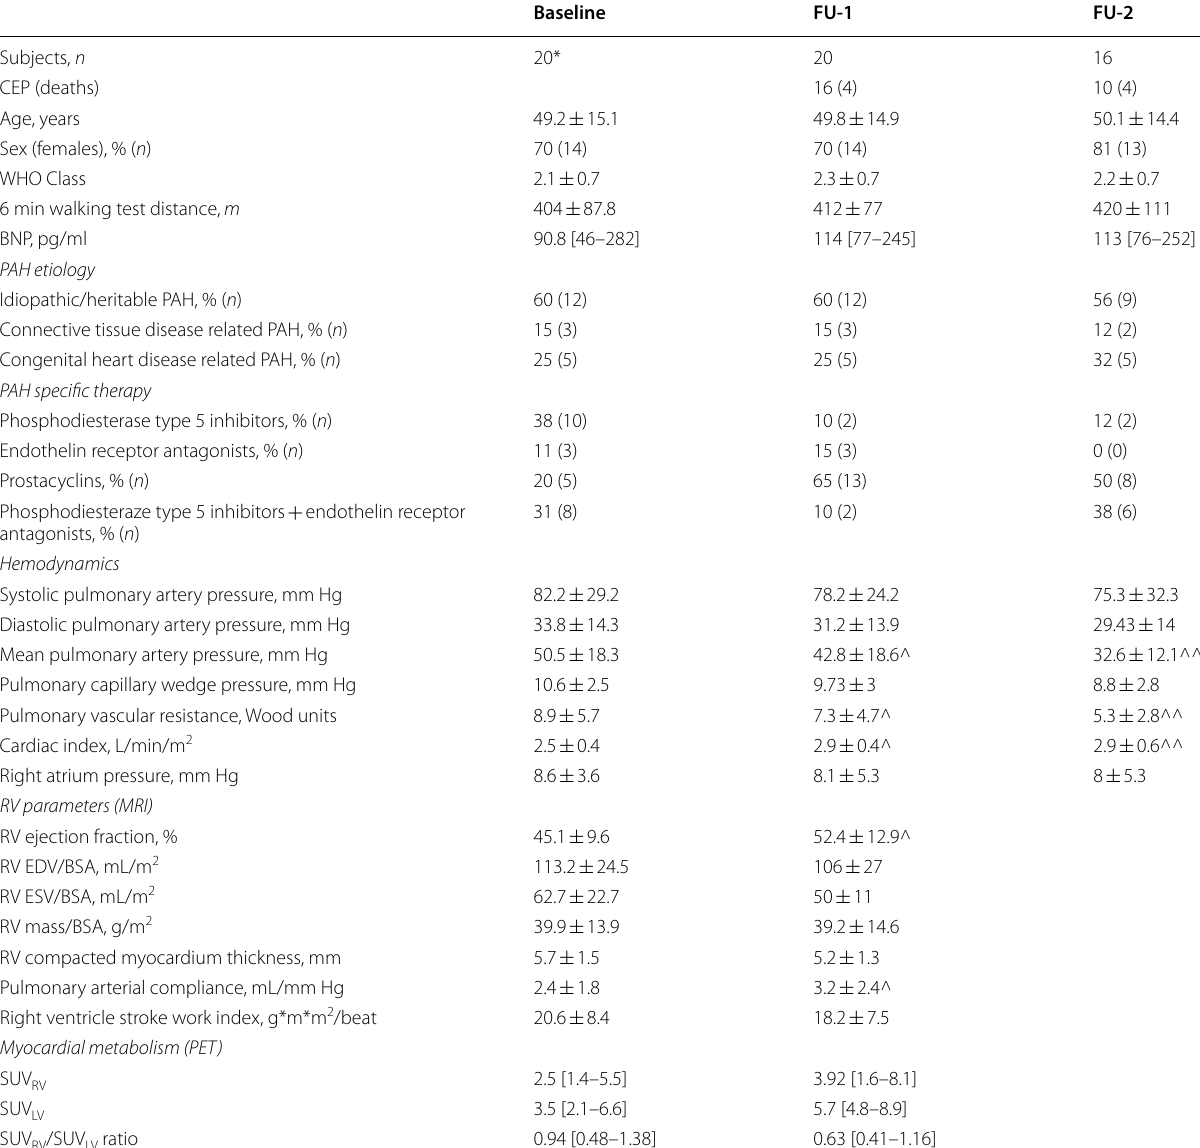
Table 1 Basic characteristics of pulmonary arterial hypertension (PAH) group at baseline and two follow-up visits (after 24 and 48